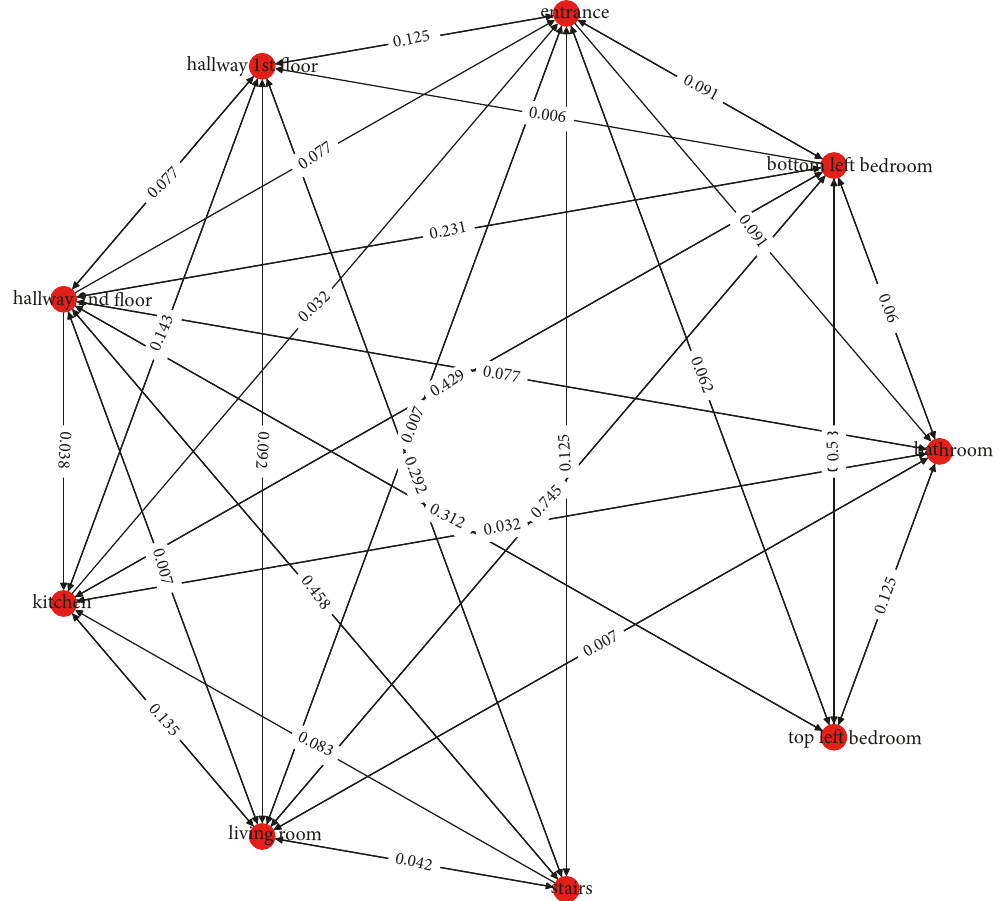
Figure 6: The directed graph of the unfiltered